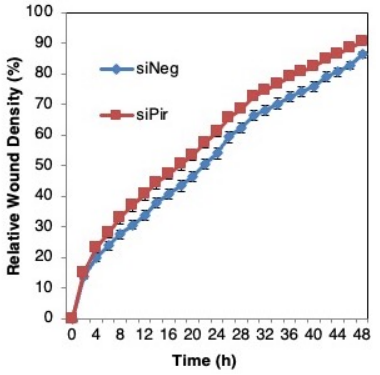
Figure 6. Pirin does not affect the migration of DLD1 colorectal cancer cells. DLD1 cells were transfected with 20 nM ON-TARGET plus Smart Pool siRNA against human PIR (siPir) or ON-TARGET plus Non-targeting Control Pool (siNeg) and grown for 48 h. Transfected cells (1.5 × 10 4 cells per well, 6 replicate wells for each condition) were seeded in 96-well ImageLock plates (Essen BioScience) and grown for a further 48 h to confluence. Cell migration was monitored at 2-h intervals for two days using IncuCyte™.